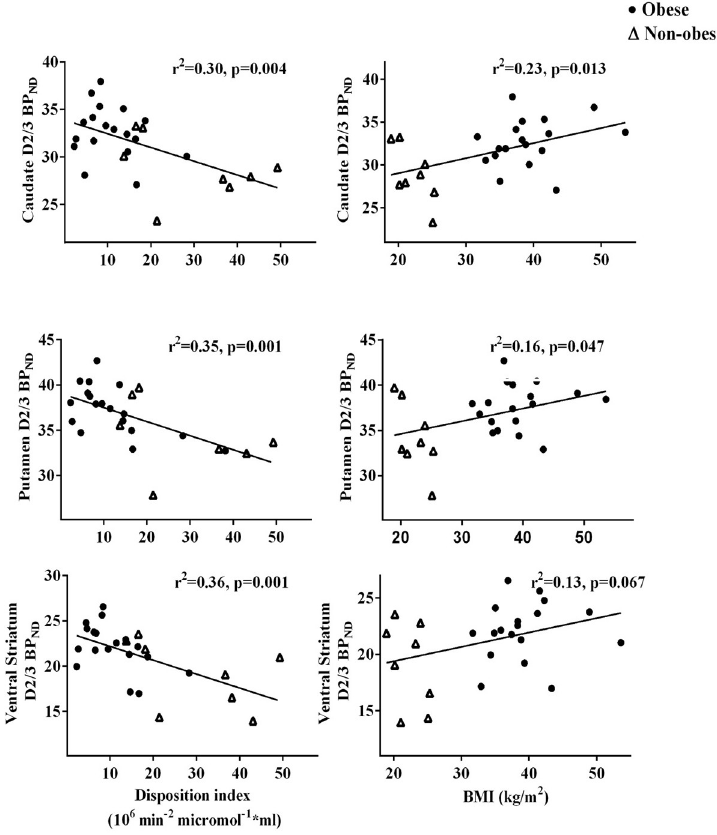
Fig 1. Linear regressions for striatal D2/3R availability with disposition index and D2/3R availability with BMI.